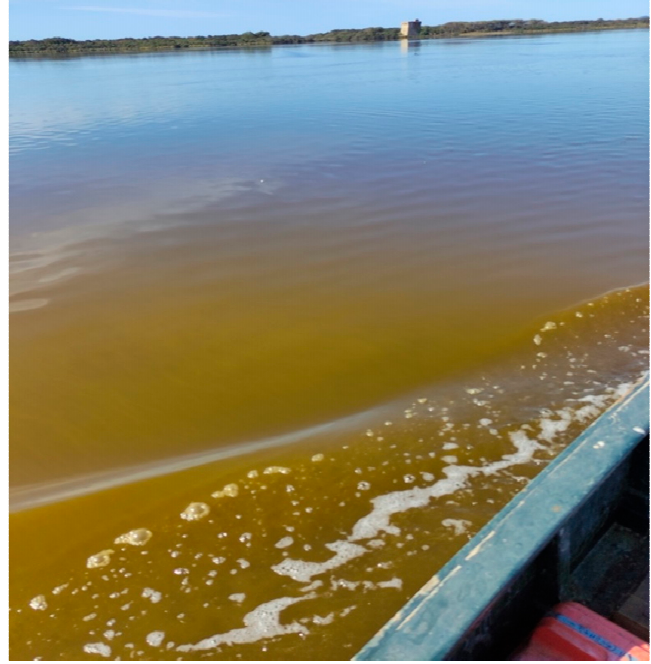
Figure 8. Bloom of the Dinophyta Alexandrium tamarense in the Burano lagoon, in September 2021. Bacillariophyceae took over in November, contributing to an intense yellow-brown colouration of the waters. Diatoms are among the few organisms that can tolerate critical environmental conditions due to ammonium abundance and low oxygen. The substitu- tion was probably induced by temperature reduction.